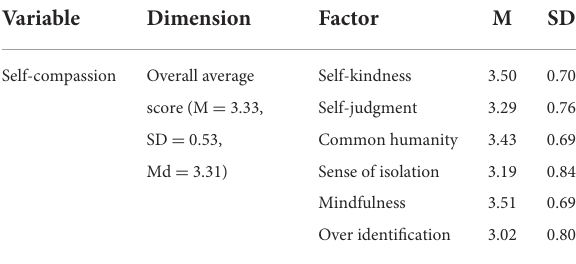
TABLE 5 Overall situation of postgraduates’ self-compassion. Variable